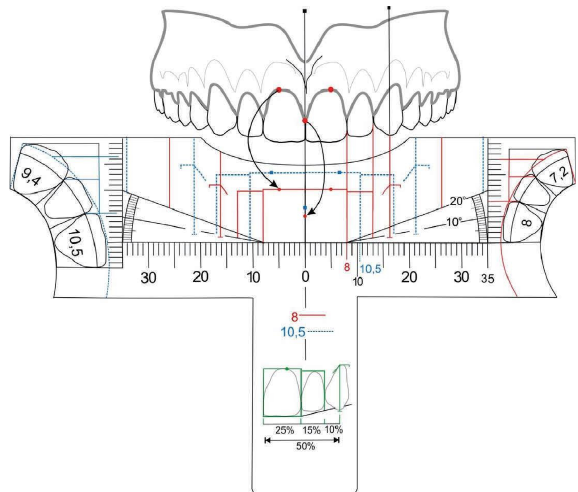
Figure 6: Upper dental arch illustration showing teeth position and inclination, the gingival zeniths and the upper central incisor papilla